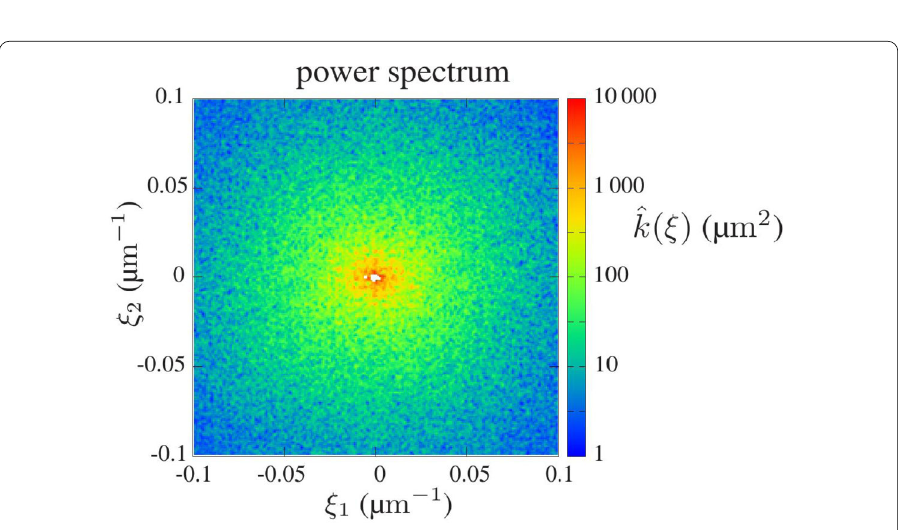
Figure 8 Power spectrum ˆ k ( ξ ) of the nonwoven FL1, estimated based on the image from Fig. 7a, as a density plot depending on ξ = ( ξ 1 , ξ 2 ) and in logarithmic scale